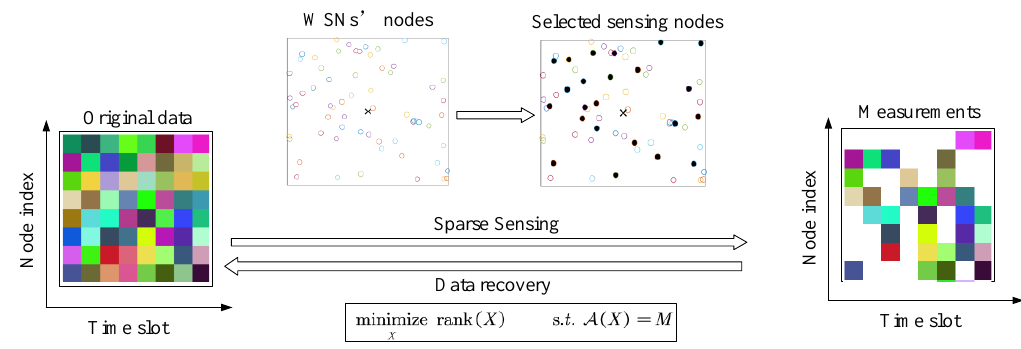
Figure 1. The data-collection method based on matrix